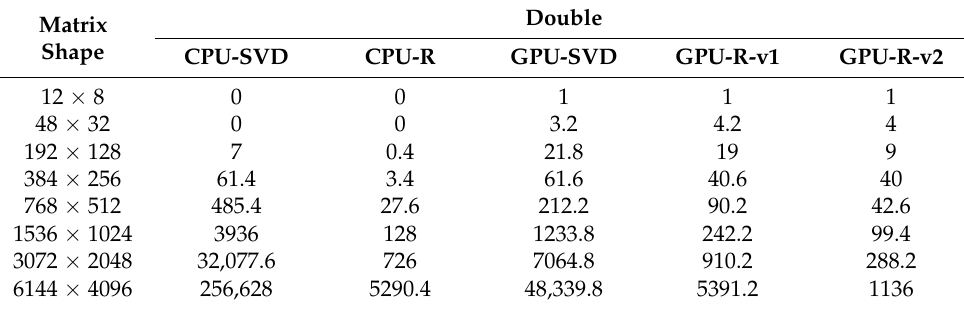
Table 2. Time in milliseconds to calculate the pseudoinverse for double matrices.